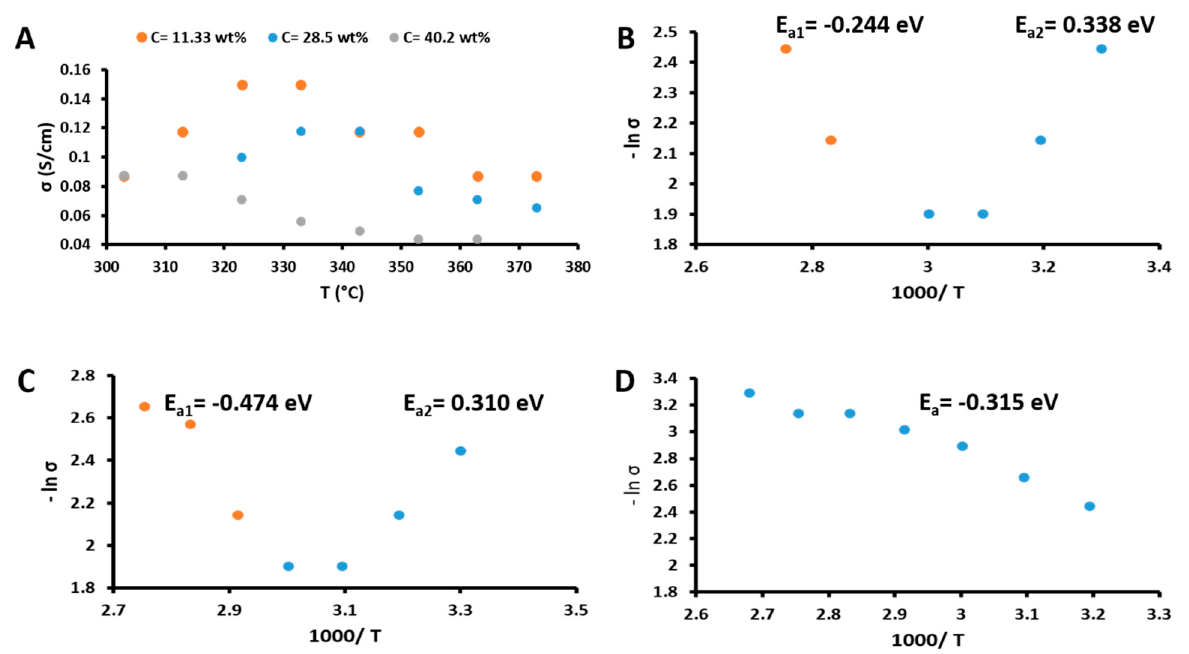
Figure 3. ( A ) Conductivity as a function of temperature. ( B – D ) are Arrhenius diagrams for the nanocomposite at low (11.33 wt%), medium (28.5 wt%), and high (40.2 wt%) TiO 2 concentrations, respectively, and a 9.11 wt% PEDOT:PSS .